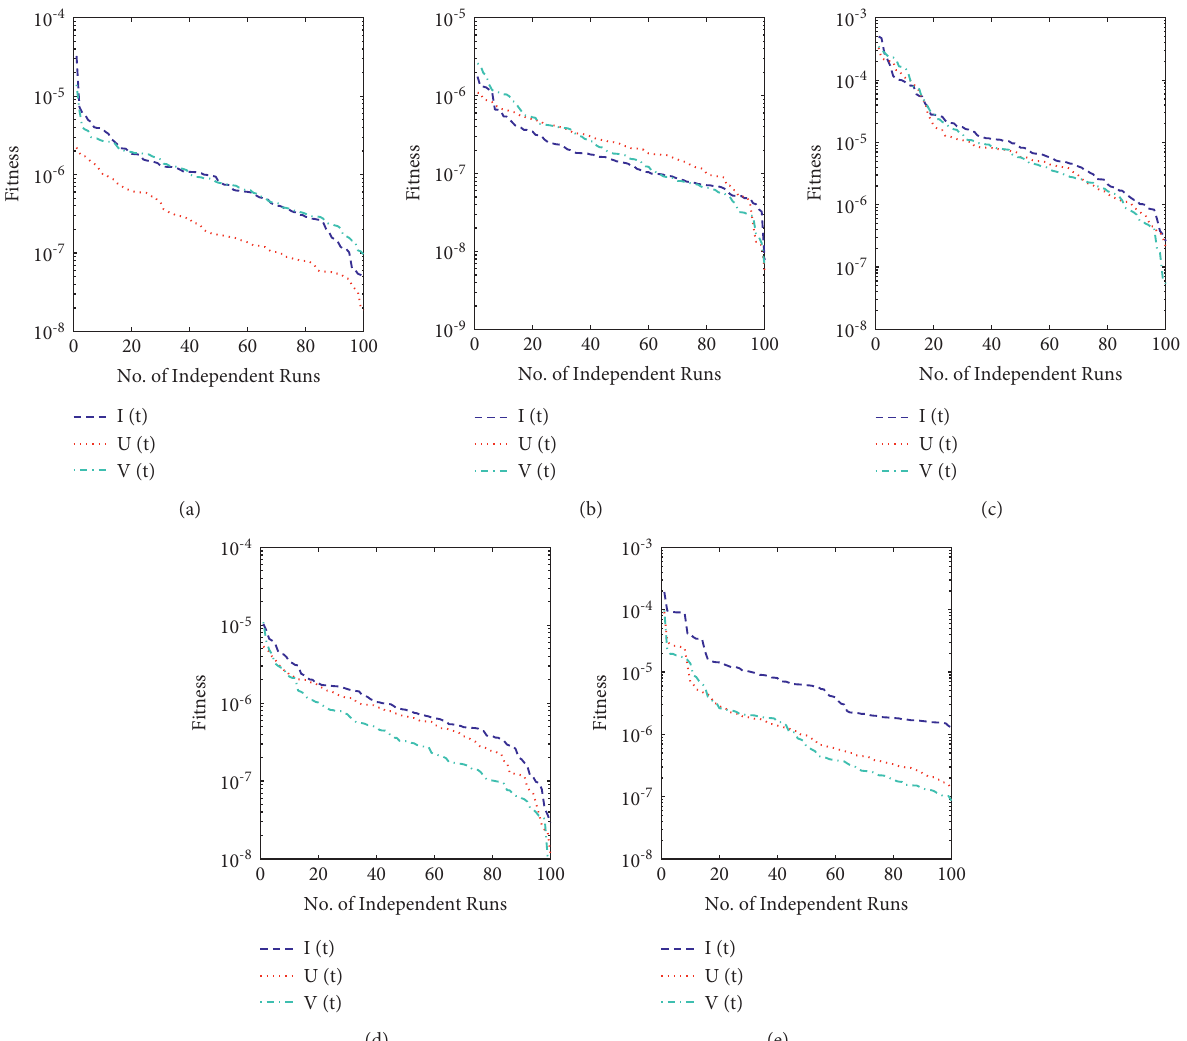
Figure 2: Fitness graphs of all the problems. (a) Fitness of problem 1, (b) fitness of problem 2, (c) fitness of problem 3, (d) fitness of problem 4, and (e) ditness of problem